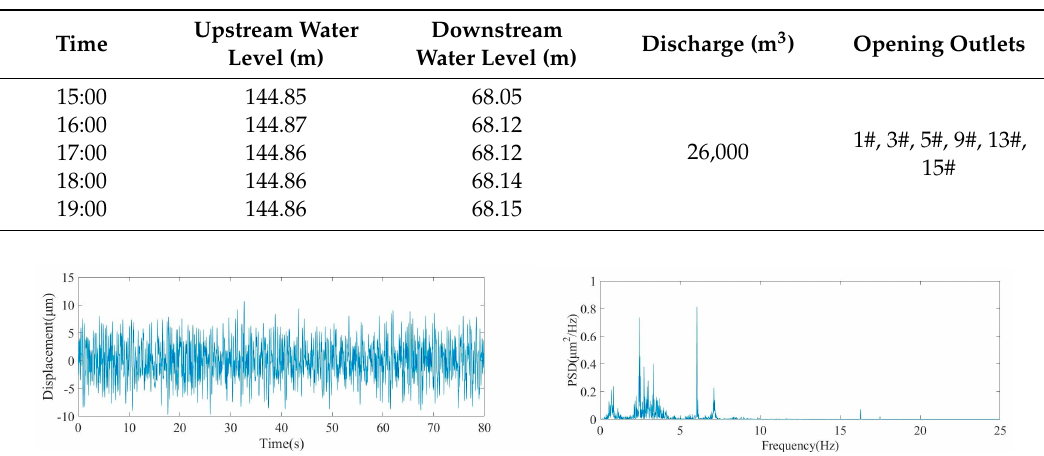
Table A1. The working condition of prototype tests.